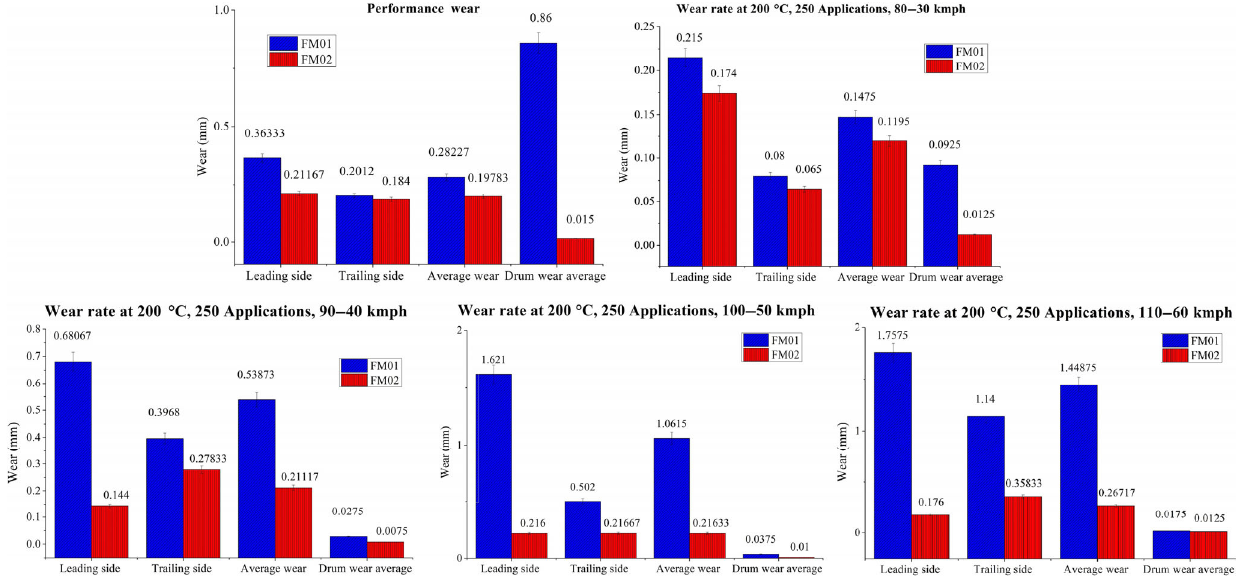
Fig. 10 Wear loss of the various conditions tested friction composites and its drum wear